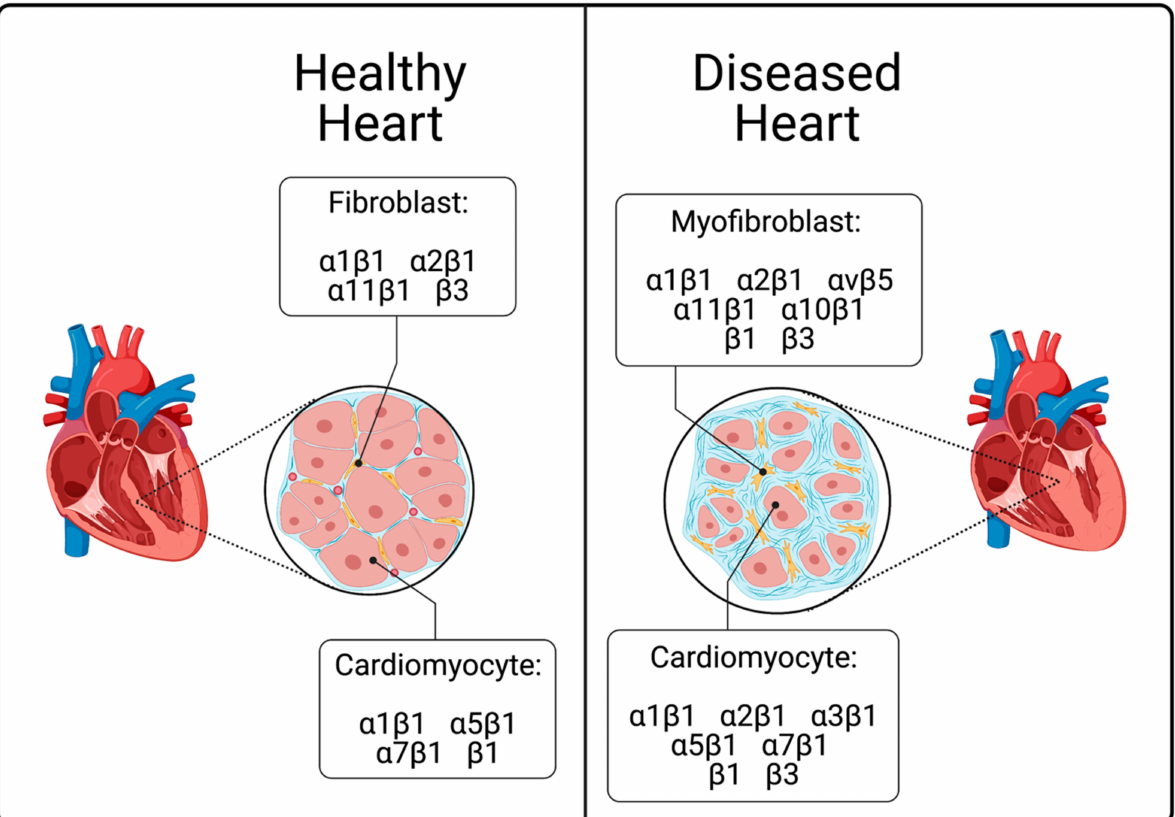
Figure 2. Summary of integrin expression in health and disease. The diseased heart possesses a higher proportion of myofibroblasts than does the healthy heart. In the diseased heart, myofibroblasts show modified expression of the α 1 β 1, α 2 β 1, α 11 β 1, and β 3 integrins, as well as non-endogenous expression of the α v β 5, α 10 β 1, and β 1 integrins. In the diseased heart, cardiomyocytes show modified expression of the α 1 β 1, α 5 β 1, α 7 β 1, and β 1 integrins, as well as non-endogenous expression of the α 2 β 1, α 3 β 1, and β 3